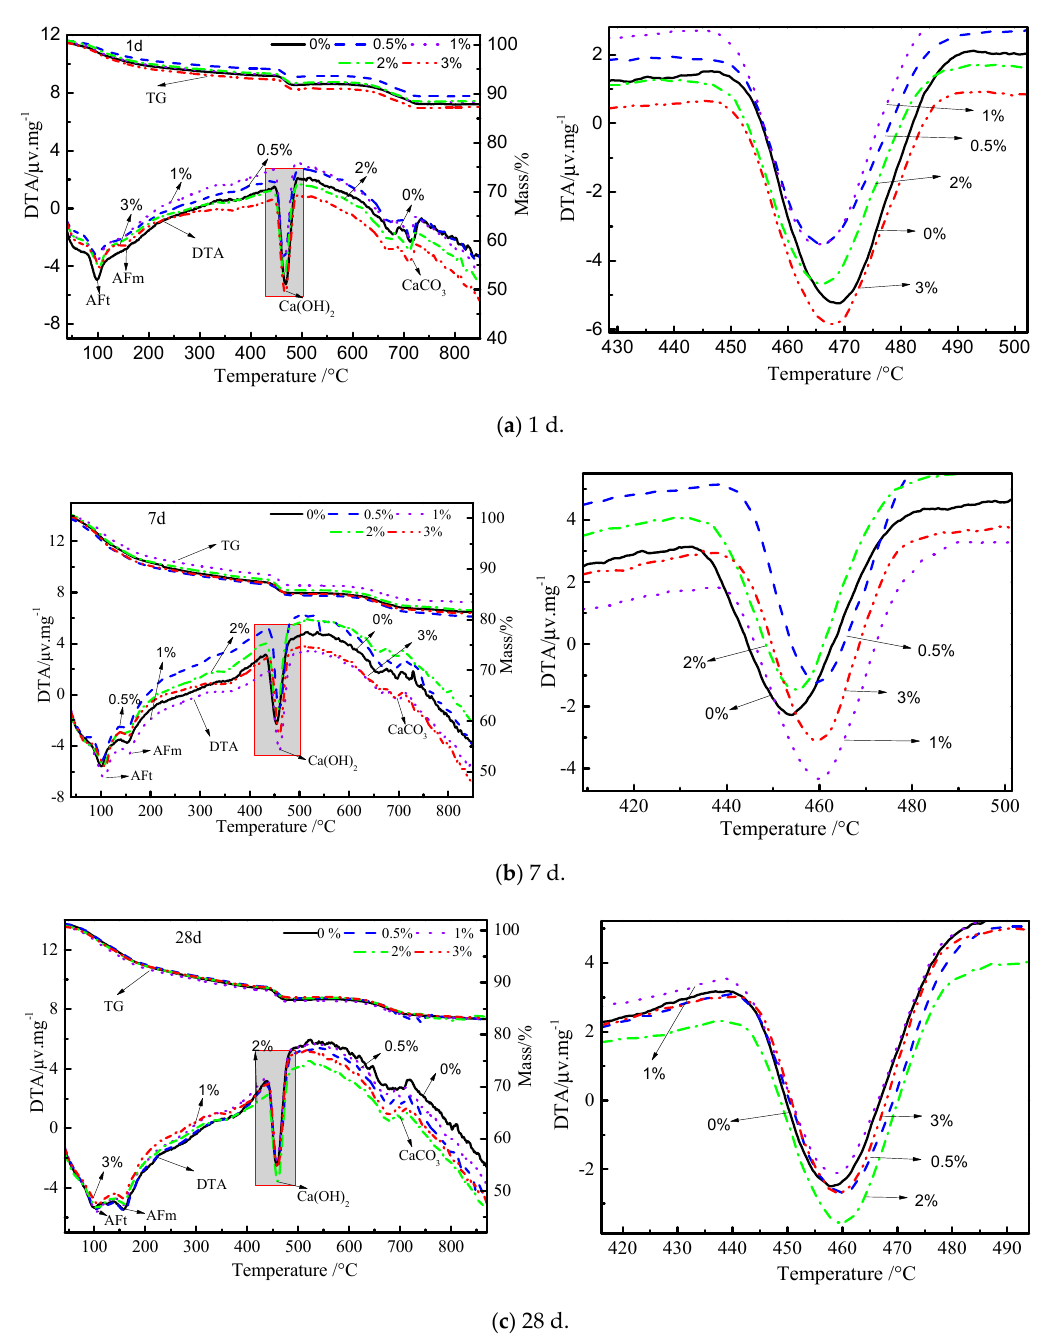
Figure 8. Thermogravimetry-differential thermal analysis (TG-DTA) results of cement paste with different contents of nano C-S-H at the age of 1, 7, and 28 days; the sub-figure on the right was a local enlarged view of the peak of Ca(OH) 2 on the left.